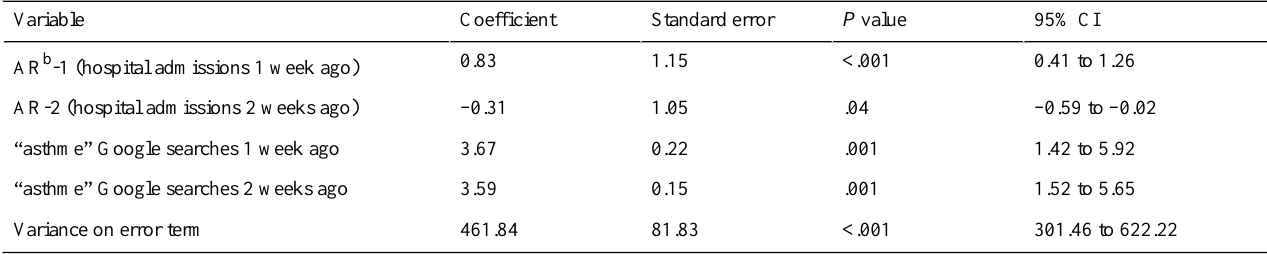
Table 1. ARIMAX a regression.